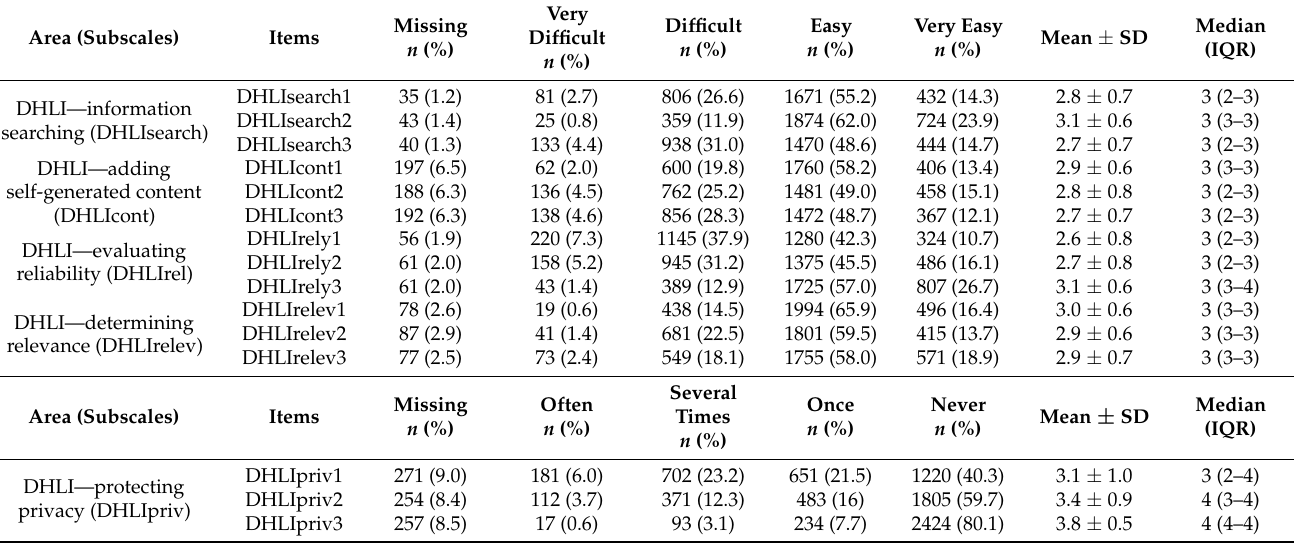
Table 1. COVID-19 Digital Health Literacy Instrument (DHLI): item responses ( n =